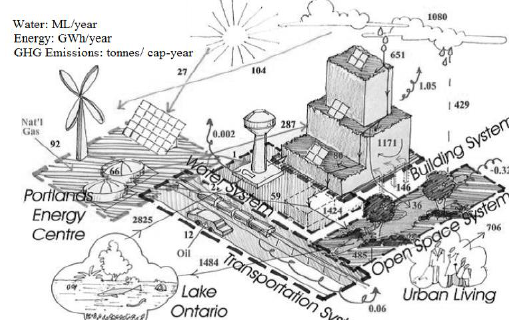
Figure 2. Presentation of the sustainable